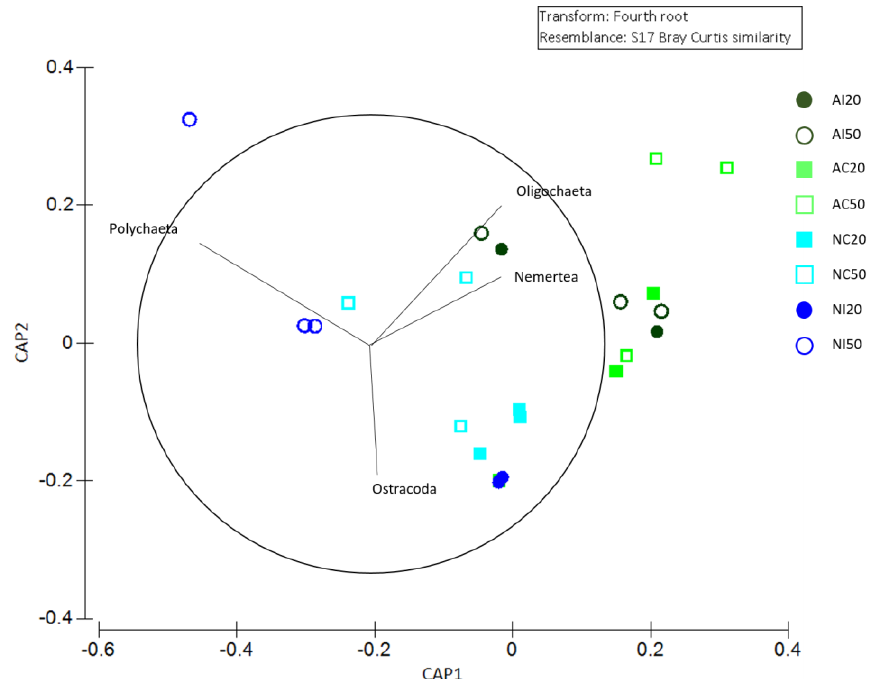
Figure 7. Canonical analysis of principal coordinates (CAP) of the interaction Ar × De factors. Dataset on rare taxa is correlated by Pearson index ( ρ > 0.35). Straight lines are vectors of taxa whose orientation and length are proportional to the most correlated plot elements. Circle represents 95% confidence interval.